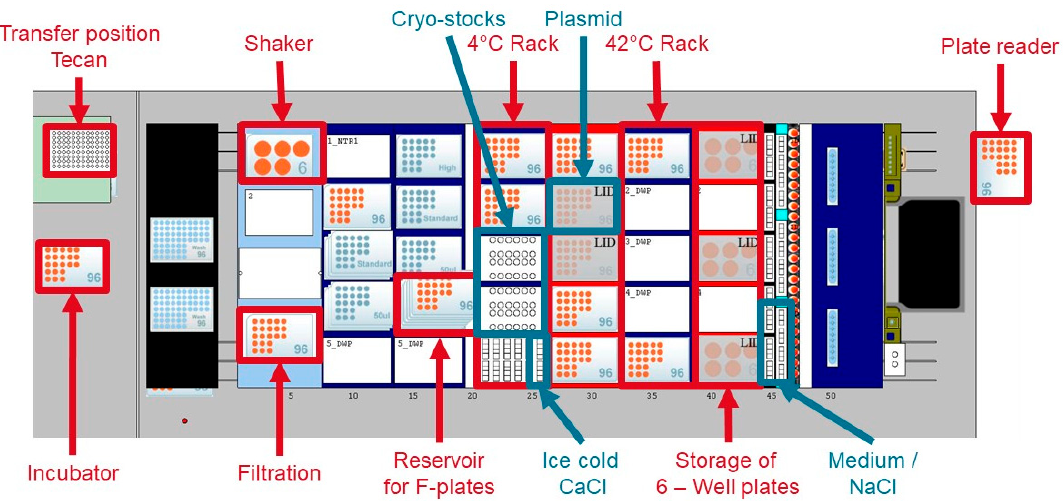
Figure 2. Deck layout of the used Hamilton Microlab Star liquid handling station. In this platform a FAME incubator (Hamilton), a Shaker (inheco Industrial Heating and Cooling GmbH, Planegg, Germany), a vacuum station, two terminable racks (each for five SBS labware) and a Synergy MX II plate reader (BioTek, Bad Friedrichshall, Germany) are mounted. Red: used Labware/Hardware; Blue: provided liquid solutions.